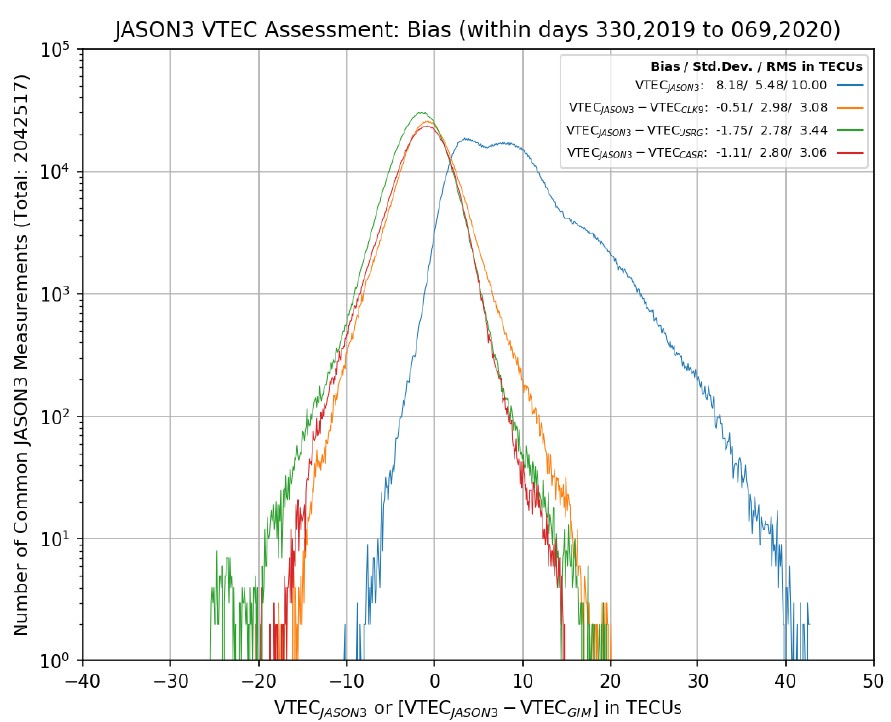
Figure 15. Histogram, in log scale for the number of counts, of the vertical total electron content (VTEC) difference of Jason–3 measurement minus real-time global ionospheric maps (RT-GIM) value during day 330 in 2019 to day 69 in 2020 for RT-GIMs of CNES ( CLK9 , orange), Universitat Politècnica de Catalunya (UPC)-IonSAT ( USRG , green), and Chinese Academy of Sciences (CAS) ( CASR , magenta),. The histogram of the reference values of Jason–3 is represented in blue. The corresponding bias, standard deviation, and RMS are indicated in the legend.